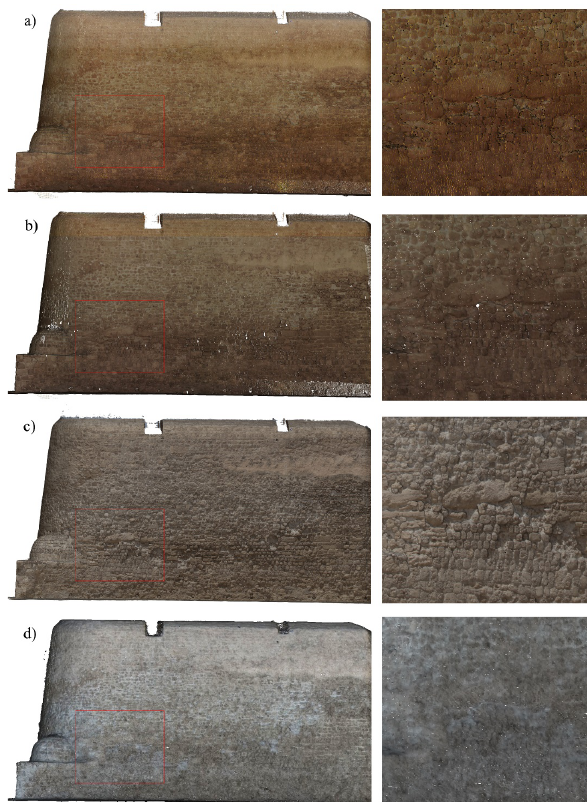
Figure 11. Zoomed area from orthoimage of the south-western bastion wall: a) original Lidar data; b) optimized Lidar data; c) UAV oblique photogrammetric dataset; d) close-range photogrammetric dataset.